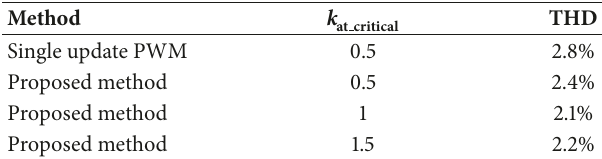
=0.5). at critical